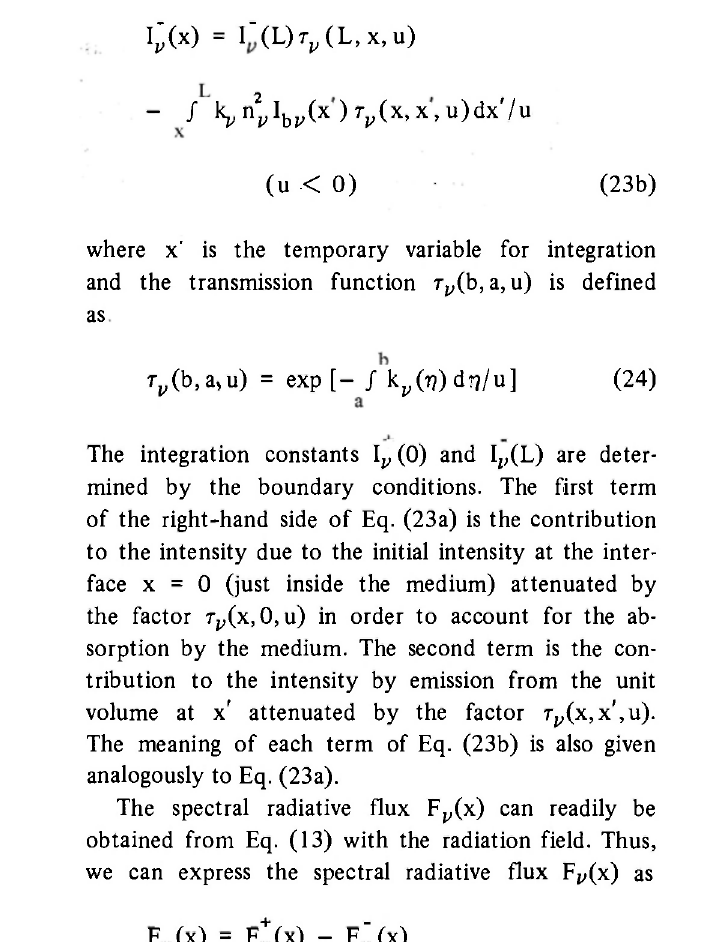
Fig. 3. Spectral absorption coefficients of glasses with iron oxide contents